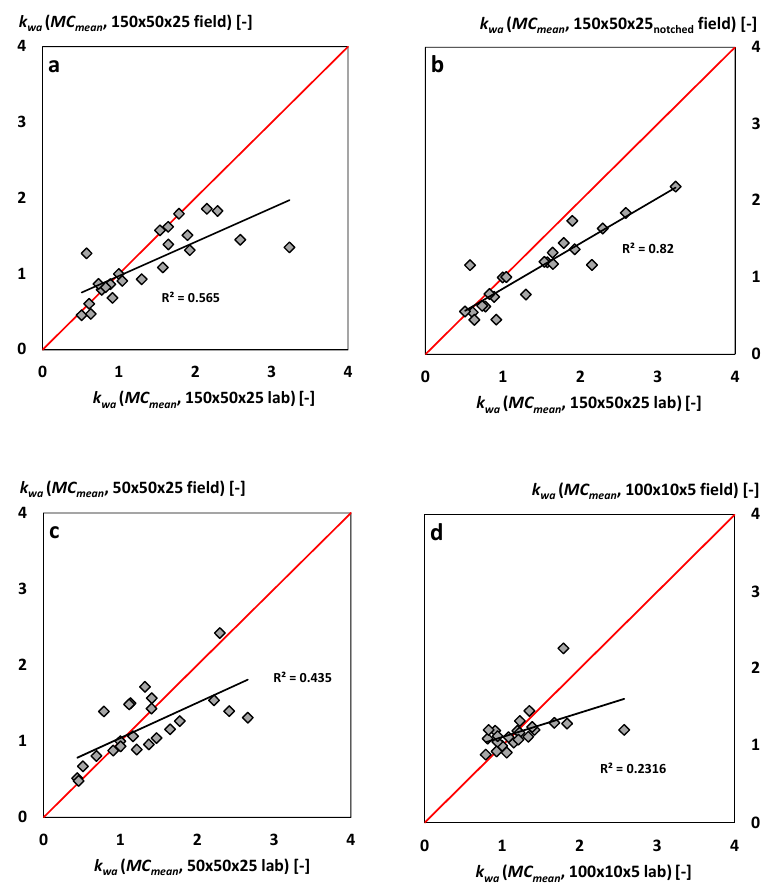
Figure 12. k wa factors based on MC mean (%) measured during outside exposure versus k wa factors of MC mean (%) measured in laboratory submersion ( a , b ), floating ( c ) and 24 h water uptake and release tests ( d ) according to [3].